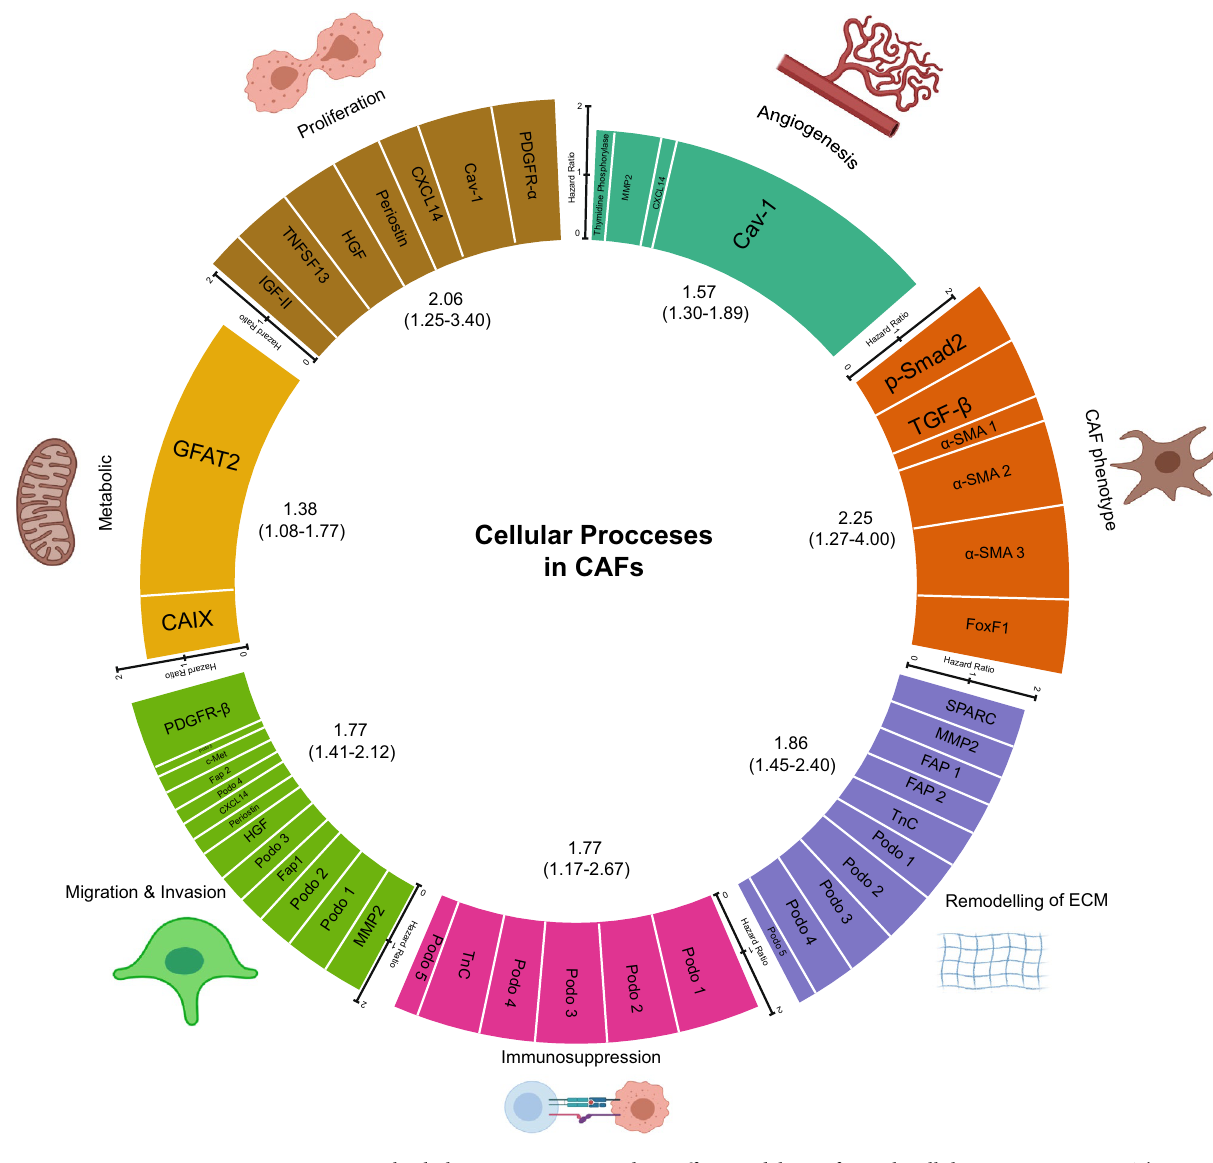
Figure 4. Ferris wheel plot summarising random-effect model HRs for each cellular process in CAFs. The height of each bar represents the HR for each process with the width of each bar indicating the % weight that each marker contributed to the random-effects model. The random-effect model HRs and 95% CIs are stated below each cellular process. Figure generated using Adobe Illustrator, 2020 (version 24.2). Icons representing each cellular process are from